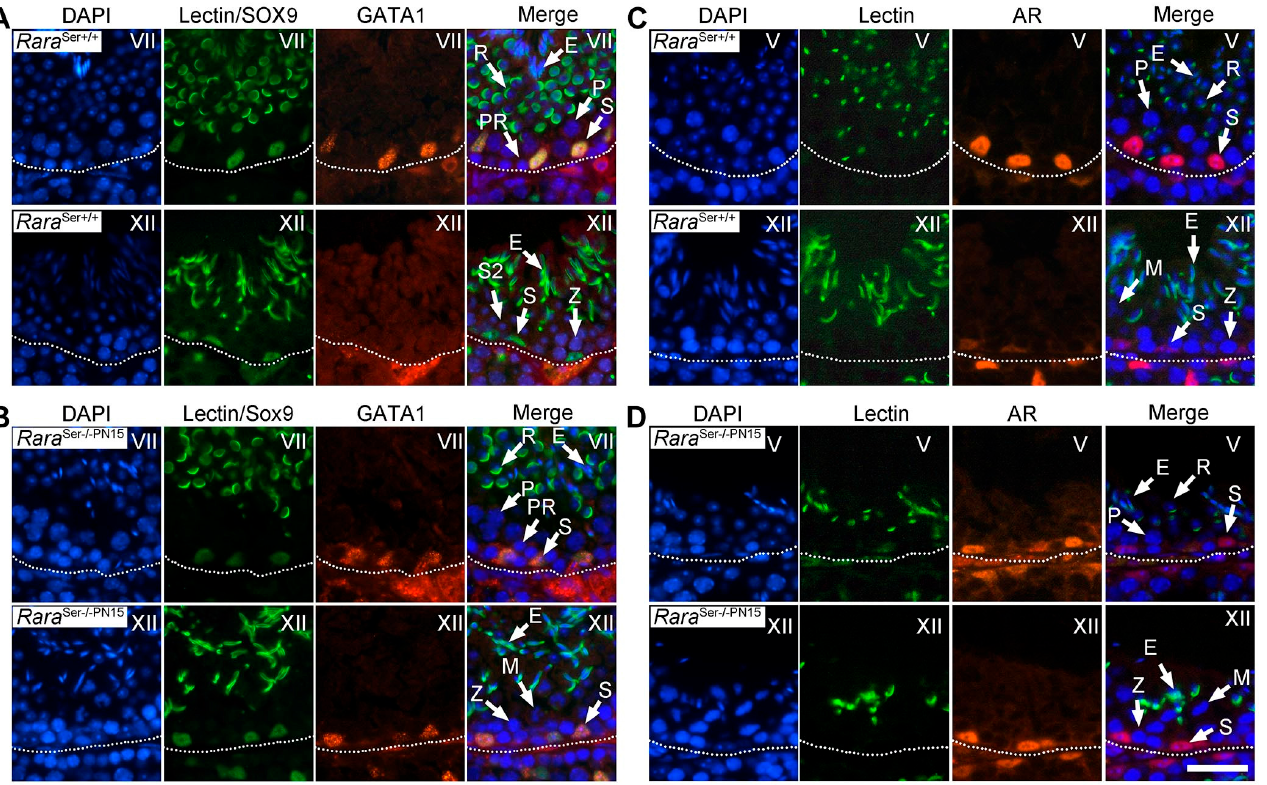
Figure 7. Loss of RARA in Sertoli cells from PN15 abrogates the periodical expression of genes in adulthood. IHC analysis on histological sections from testes of 4-month-old control and Rara Ser − / − PN15 mutant mice. ( A , B ) In the control, GATA1 expression (red signal) was strong in Sertoli cell nuclei at stage VII and at the background level at stage XII of the seminiferous epithelium cycle. In the Rara Ser − / − PN15 testis, GATA1 was uniformly expressed at all epithelial stages. Sertoli cell nuclei were identified using an antibody directed against SOX9 (green signal in Sertoli cells). ( C , D ) In the con- trol, AR expression (red signal) was strong in Sertoli cell nuclei at stage V and weak at stage XII. In the Rara Ser − / − PN15 testis, AR was uniformly expressed at all epithelial stages. Nuclei were counter- stained by DAPI (blue signal). In ( A – D ), the acrosomal system is identified by Alexa Fluor 488- conjugated peanut agglutinin (green signal), allowing proper staging. The dotted lines indicate the periphery of seminiferous tubules. Legend: E, elongated spermatids; M, spermatocytes in meta- phase; PR and P, preleptotene and pachytene spermatocytes, respectively; R, round spermatids; S, Sertoli cells; S2, type 2 spermatocytes; Z, zygotene spermatocytes. Roman numerals designate stages of the seminiferous epithelium cycle. Scale bar: 70 μ m.